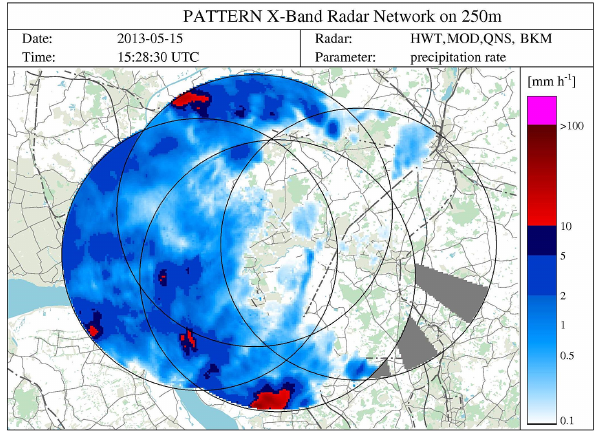
Figure 10. Composite of the precipitation fields of all four PAT- TERN radars for 15 May 2013,